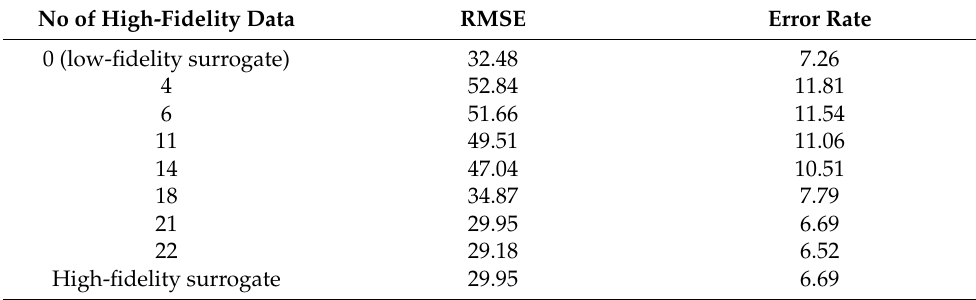
Table 2. RMSE value between the HF data and multi-fidelity surrogate (MFS) model (HF data average = 447.47). No of High-Fidelity Data RMSE Error Rate 0 (low-fidelity surrogate)